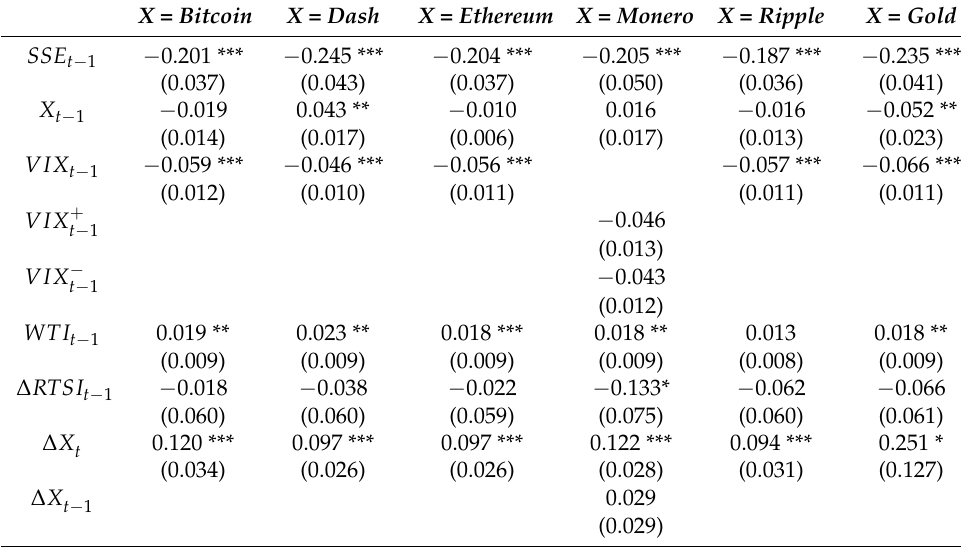
Table 14. Estimation results for RTSI during